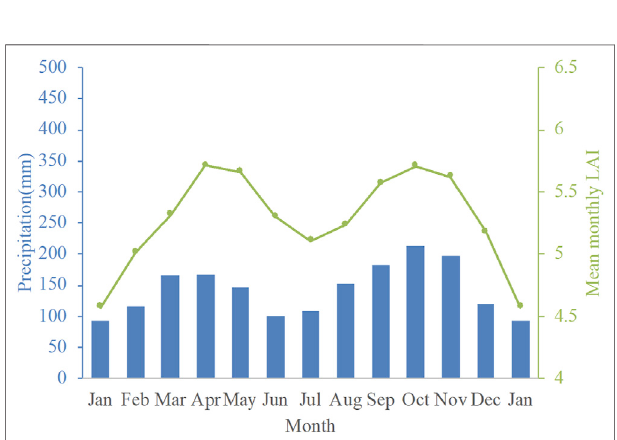
FIGURE 12 | Annual courses of monthly-average precipitation and LAI over the Congolese forests. Monthly data were accumulated over the period February 2000 to December 2019.